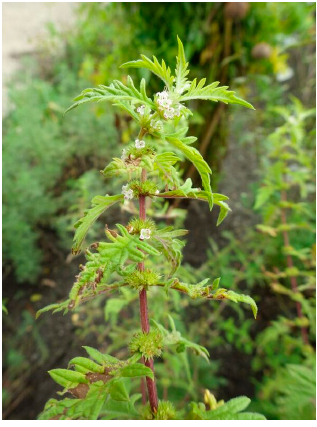
Figure 1. Lycopus europaeus .